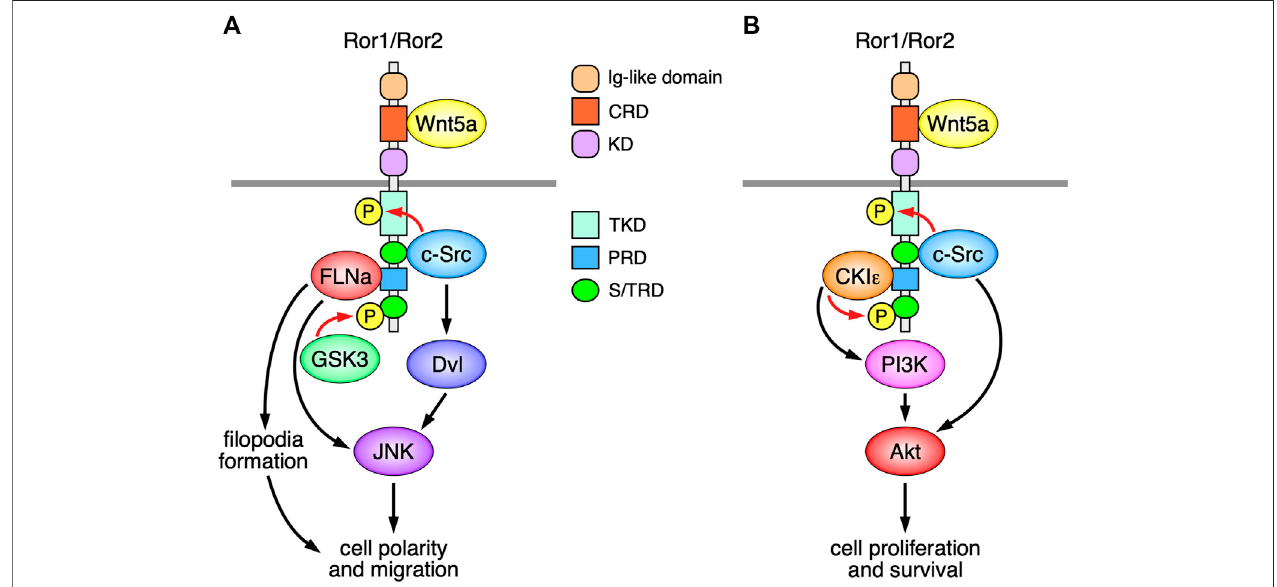
FIGURE 1 | Schematic representation of the Ror-family receptors (Ror1/Ror2)-mediated signaling, implicated in the regulation of Wnt5a-induced cell polarity, migration, proliferation, and survival. (A) The Ror-family receptors induce fi lopodia formation and JNK activation via theinteractionwith FLNa, leadingto theregulationof cellpolarityandmigration.Wnt5a-Rorsignalingcanalsoinduceactivationofc-SrcandDvl,leadingtotheactivationofJNK.c-SrcandGSK3,respectively,phosphorylate the Ror-family receptors on their tyrosine and serine/threonine residues, both of which are required for Wnt5a-induced cell polarity and migration. (B) Wnt5a-Ror signaling can activate PI3K-Akt pathway presumably via CKI ε associated with Ror1/Ror2, which in turn promotes cell proliferation and survival. c-Src, activated by Wnt5a-Ror signaling, can also induce activation of Akt, thereby contributing to cell proliferation and survival.